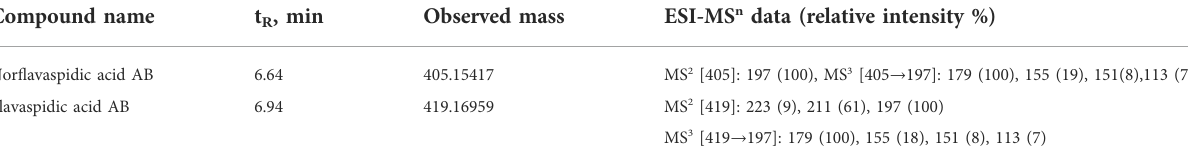
TABLE 2 Identi fi cation of antimicrobial metabolites from D. crassirhizoma using UHPLC-MS/MS.